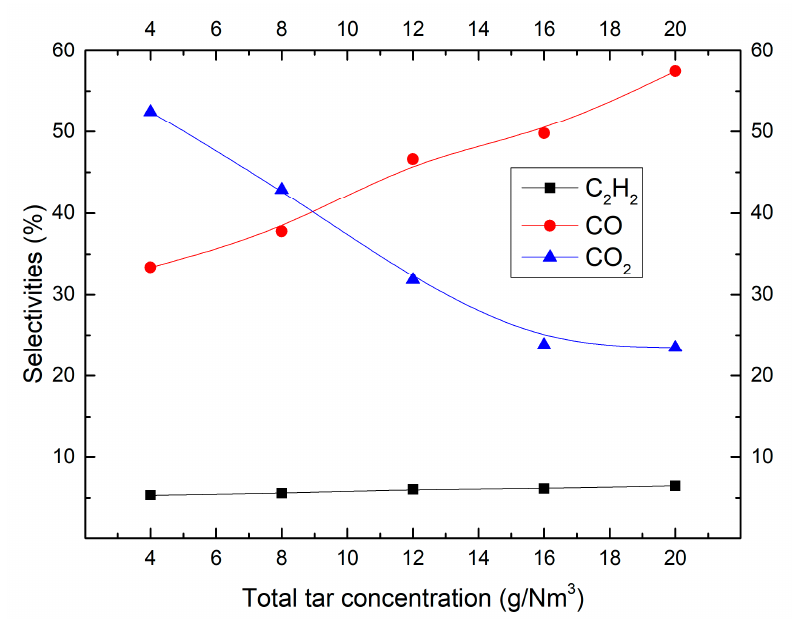
Figure 3. Effect of tar concentration on the selectivity of CO, CO 2 and C 2 H 2 .